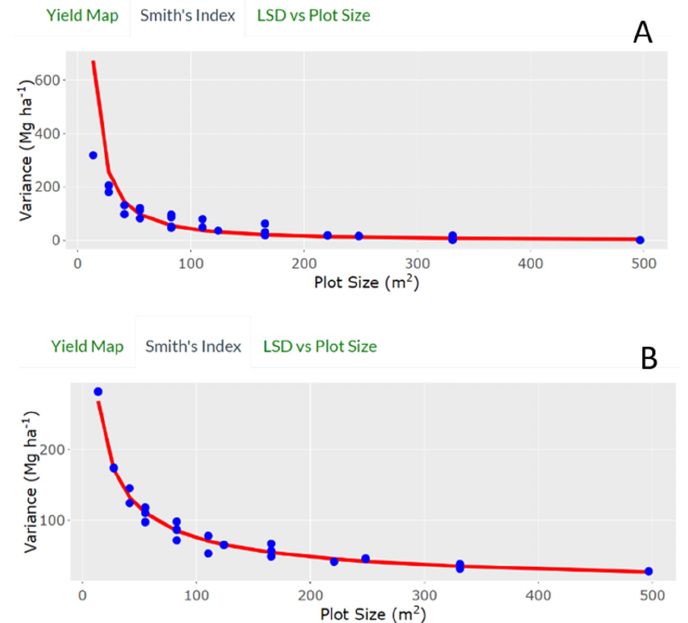
Figure 6. Output from a Shiny application to automate data compilation for uniformity trials. The output data include Smith’s index along with a plot regressing plot variance on plot area. Fields ISU.B4 ( A ) and ISU.SE ( B ) are used in this example. Relationship of Variance and Plot Size. Available online: https://marin-harbur.shinyapps.io/plot_size_app_for_uploaded_data/ (accessed on 18 June 2021). Agronomy 2021 , 11 , x FOR PEER REVIEW